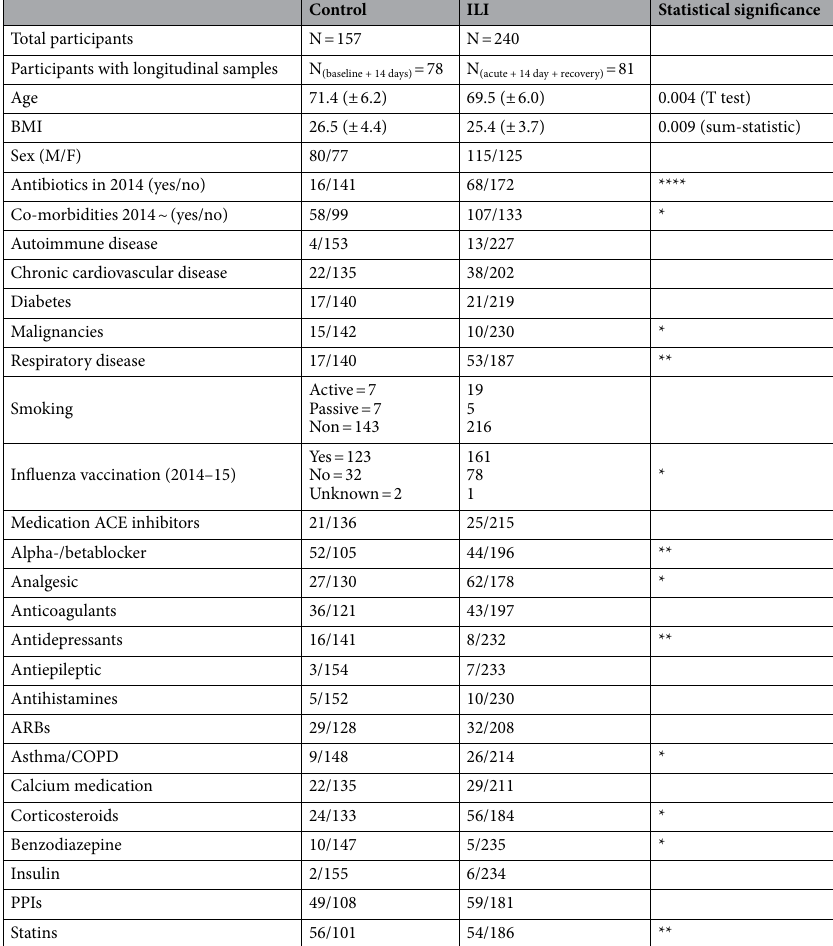
Table 1. Baseline information from participants in this study. ~Participant has a comorbidity (respiratory, cardiac, diabetes, kidney, transplant, autoimmune, asplenia, leukemia, lymphatic cancer, malignancy). Asterisks indicate differences detected between the control and ILI groups: ****FDR < 0.0001, ***FDR < 0.001, **FDR < 0.01; *FDR <